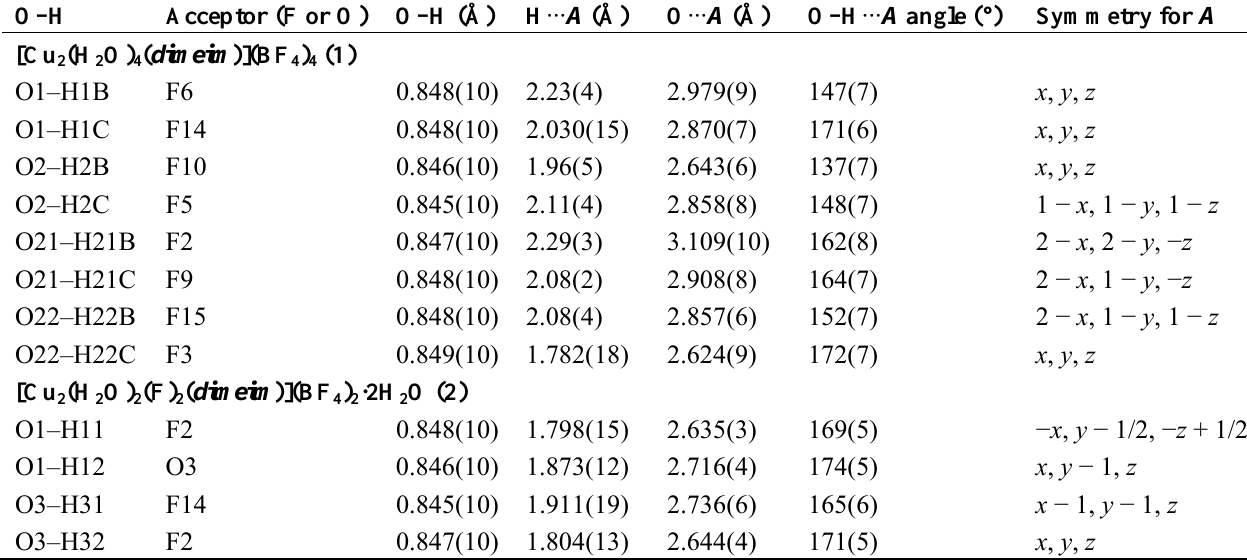
Table 1. Main hydrogen bonds in complexes 1 and 2 involving water molecules as donor groups and F − or lattice water as acceptor groups. Weak N–H···F contacts present in the crystal structures are not displayed in the table and may be found in the CIF deposited as supplementary